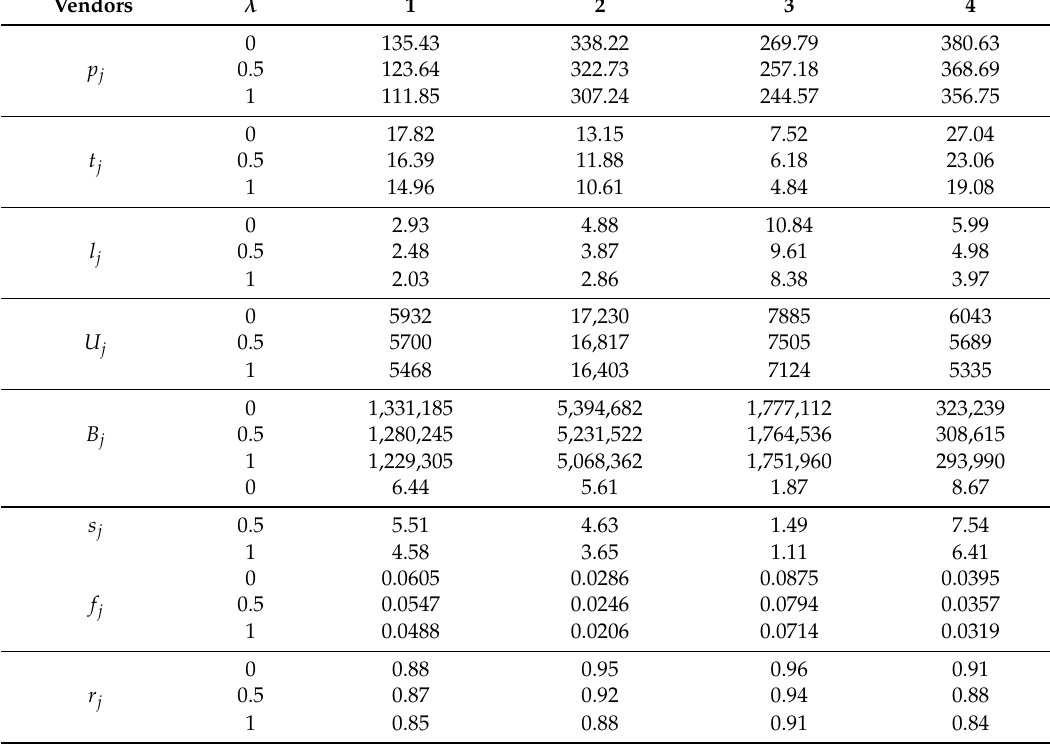
Table 7. Optimistic, pessimistic and most likely value of the parameter for case